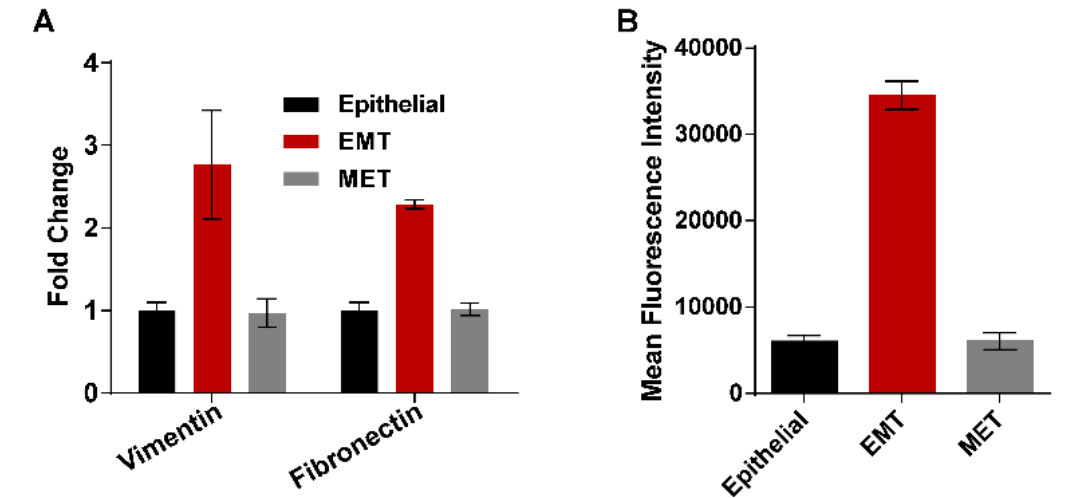
Figure 6. Gene expression studies by real-time PCR and flow cytometry. ( A ) Comparison of expression of vimentin and fibronectin genes in epithelial, EMT, and mesenchymal to epithelial transition (MET) cells; ( B ) vimentin expression studied at the protein level using anti-vimentin antibody in flow cytometry.